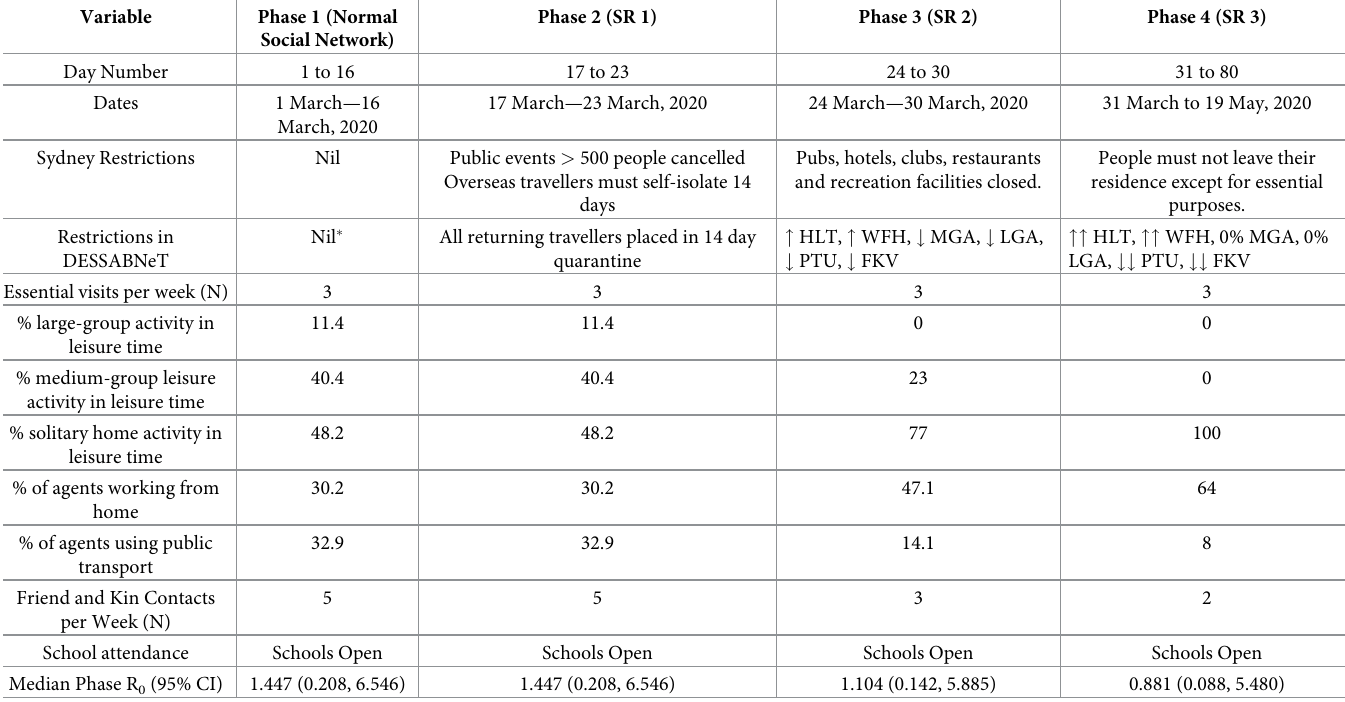
Table 3. Social restrictions for the Sydney